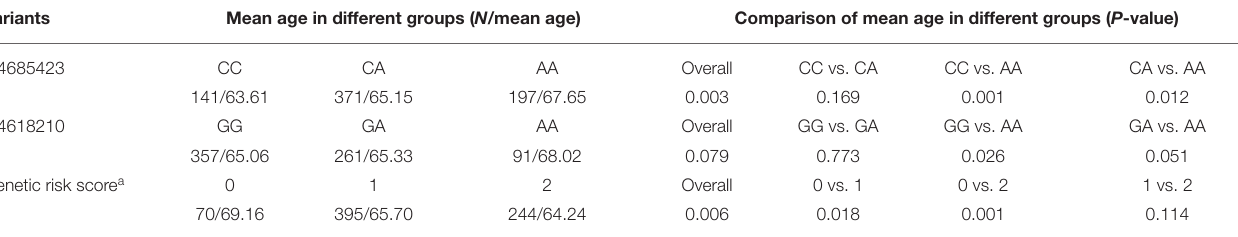
TABLE 3 | Association between the rs4685423 and rs4618210 polymorphisms and genetic risk score with mean age at ischaemic stroke onset. Variants Mean age in different groups ( N /mean age) Comparison of mean age in different groups ( P -value) rs4685423